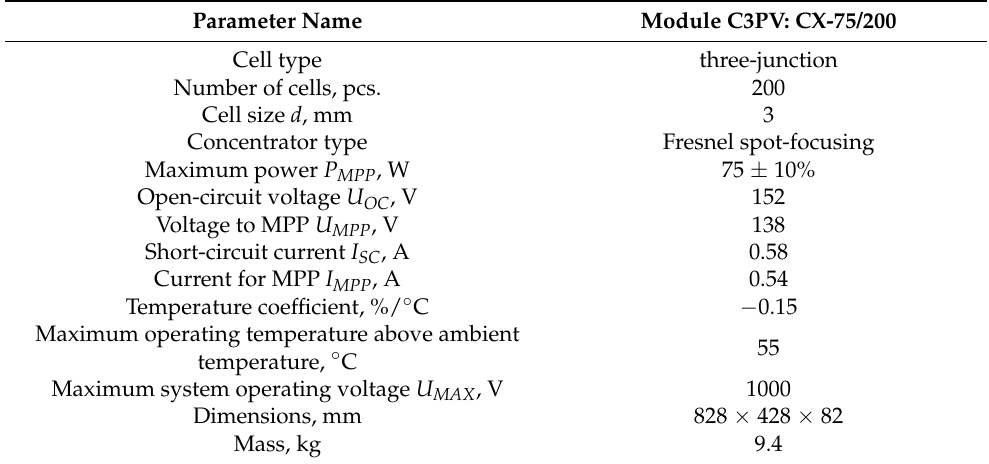
Table 2. Nominal parameters of CX-75/200 module [21].